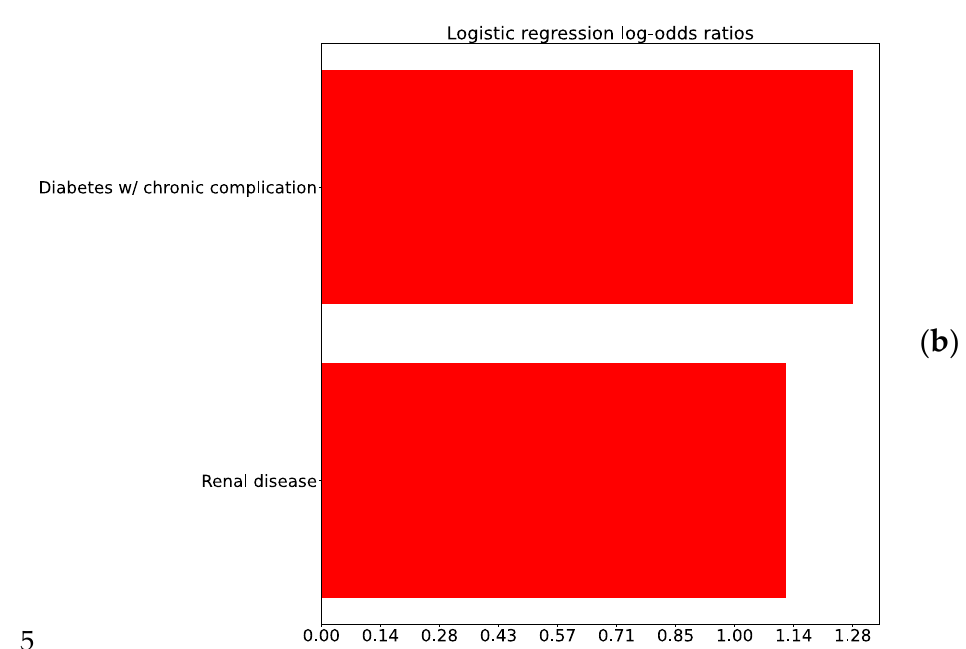
Figure A2. Logistic regression log-odds ratio correlating comorbidities to the outcome for comparison 2: ( a ) Raw log odds ratios and ( b ) Controlled for age.